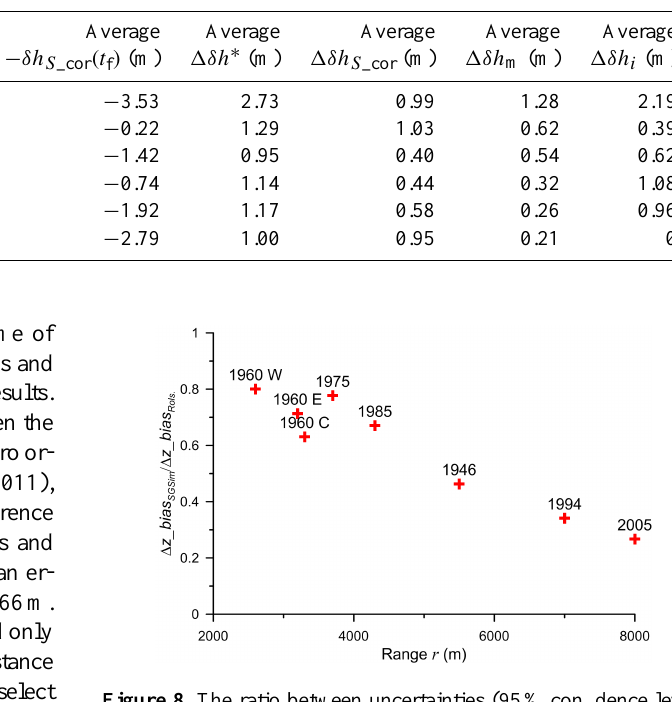
Table 3. The average elevation change during periods defined by the DEMs before ( δh) and after (δh ∗ ) the seasonal correction, the seasonal correction (δh S _cor ) corresponding to DEM at time t s and t f (the correction at t f is shown with minus sign since this correction term has minus in front of it in Eq. 2), the uncertainties (95% confidence level) of seasonally corrected elevation change ((cid:49)δh ∗ ) and the uncertainty contribution from the seasonal corrections ((cid:49)δh S _cor ) , DEM errors ((cid:49)δh m ) and interpolation of data gaps ((cid:49)δh i ) . All values were originally calculated in terms of volumes but are here averaged over the area ¯ A = (A(t f ) + A(t s ))/ 2.